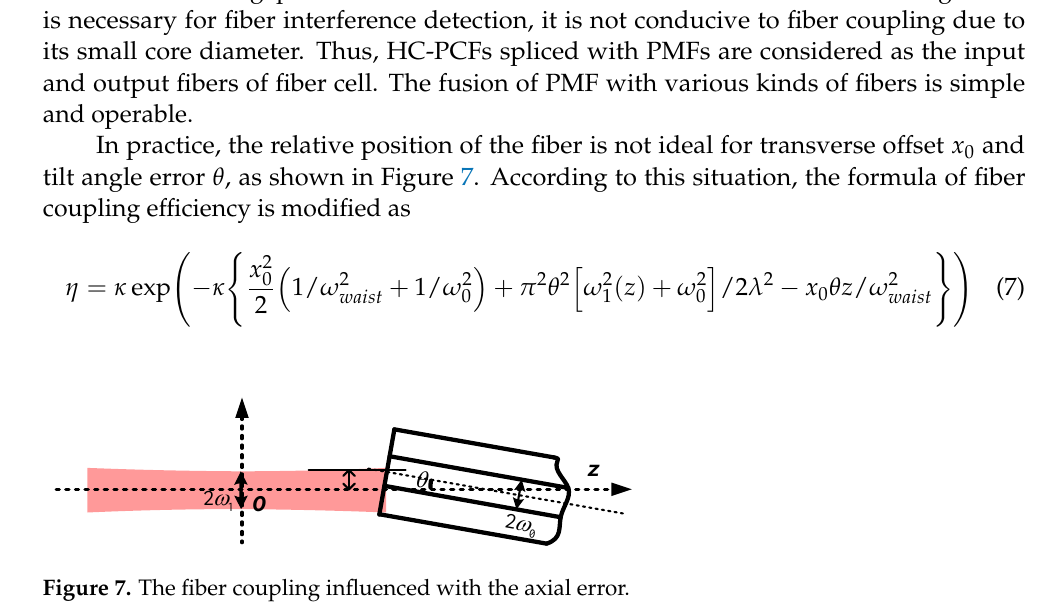
Figure 7. The fiber coupling influenced with the axial error.